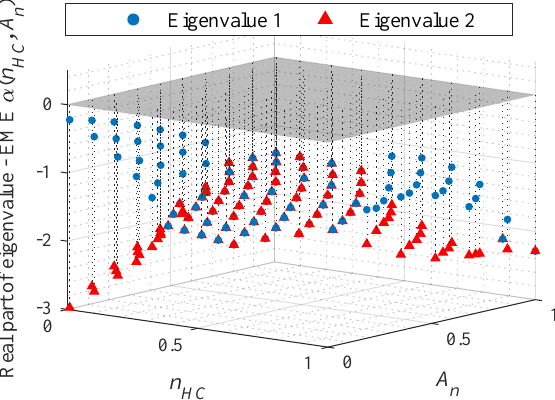
Figure 17. The real part of eigenvalue of A ( α ) for the EME ( α = [ n HC , A n ] )